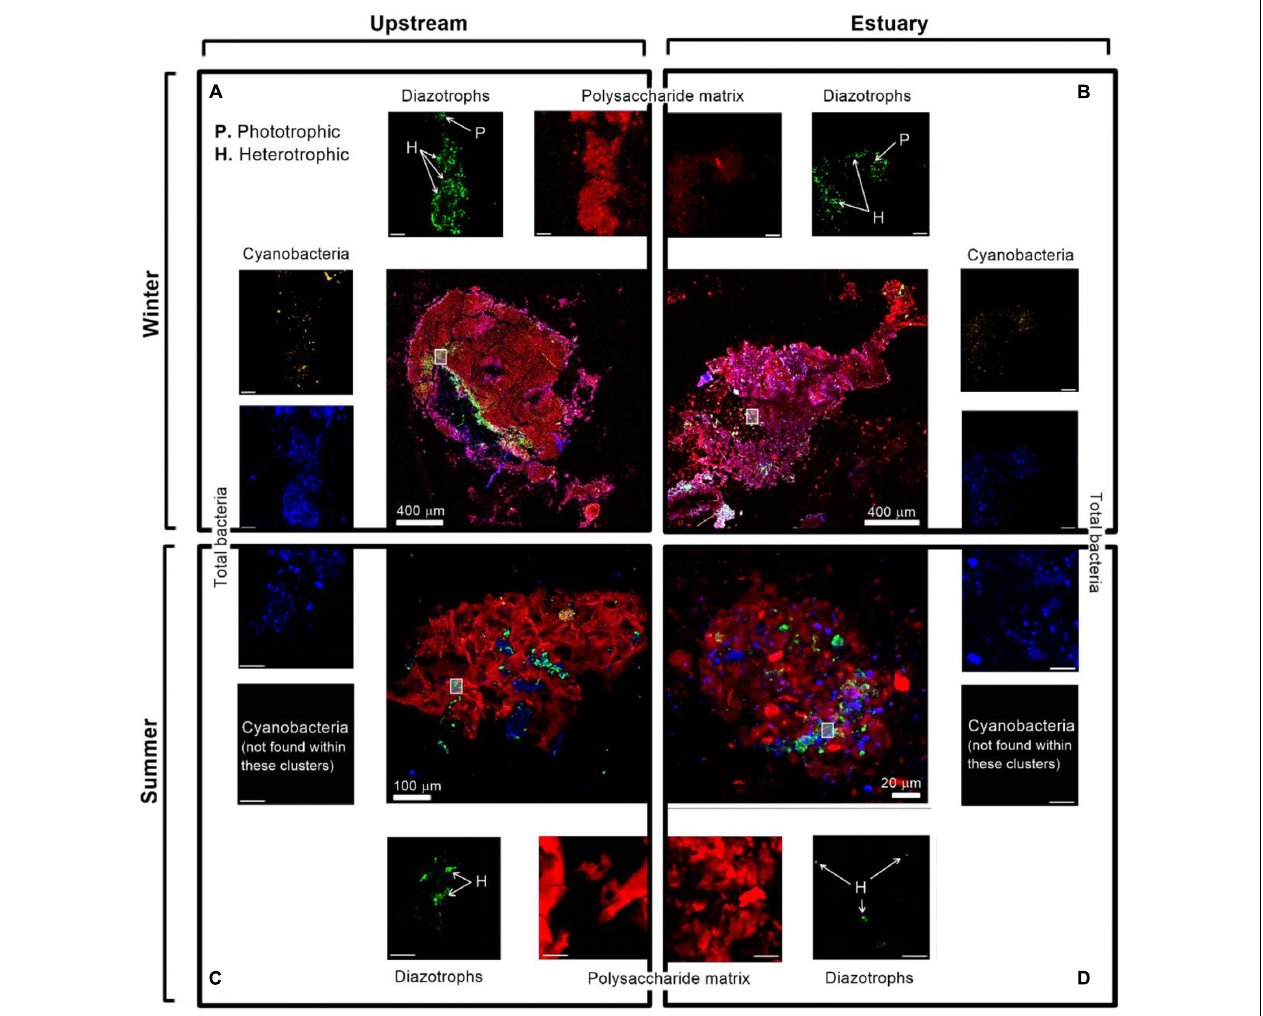
FIGURE 7 | Immunolabeling micrograph images of diazotrophs associated with aggregates collected from the Qishon River ( A,C - stream; B,D - Estuary) during the winter (top panels) and summer time (bottom panels). Images were captured by a confocal laser scanning microscope with a double close-up of bacteria associated with aggregates. Images were taken in four layers (sub-plots around each aggregate) as cyanobacteria by autofluorescence of the phycoerythrin pigment (orange/white), diazotrophs by immunolabeling of nitrogenase [green, bacteria by DAPI (blue), and polysaccharides by ConA (red). The mark on the aggregates represents a close-up of the image. The reported scale bar in the top inserts is 10 µ m, while the scale bar in the bottom inserts is 5 µ m. H refers to heterotrophic diazotrophs and P to phototrophic diazotrophs, distinguished by the phycoerythrin pigment]. Additional microscopy images are provided in the Supplementary Figure 1